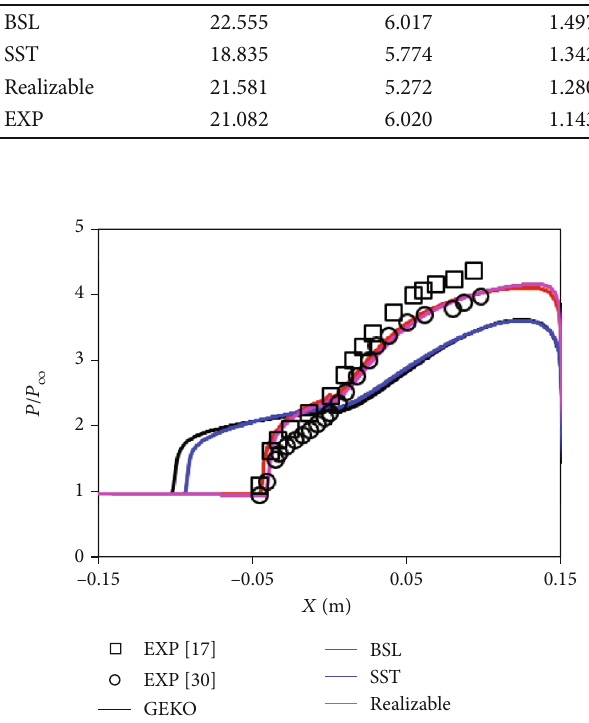
Figure 9: Nondimensional pressure distribution along the bottom surface.